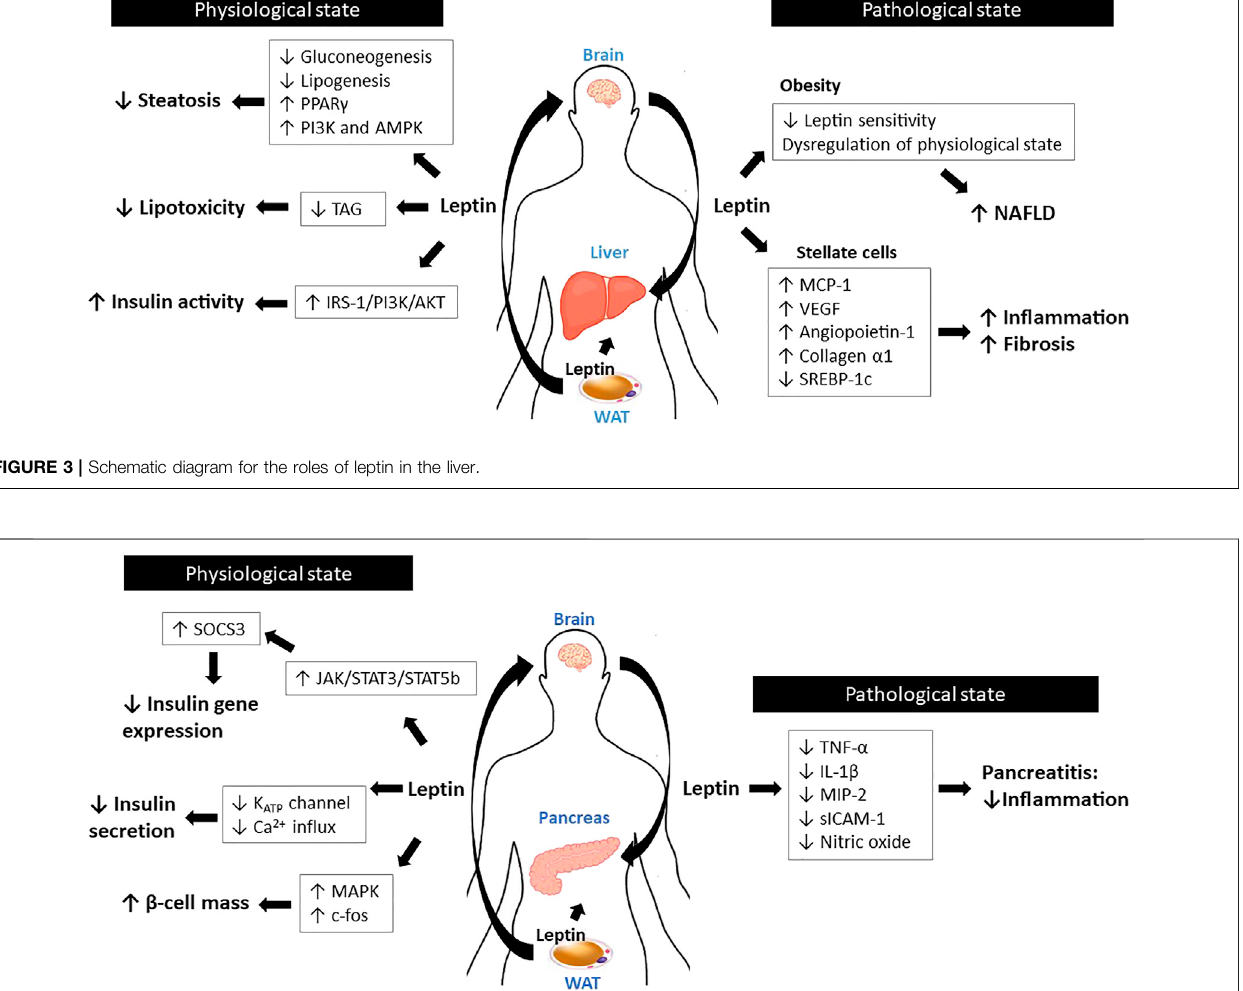
Frontiers in Pharmacology |